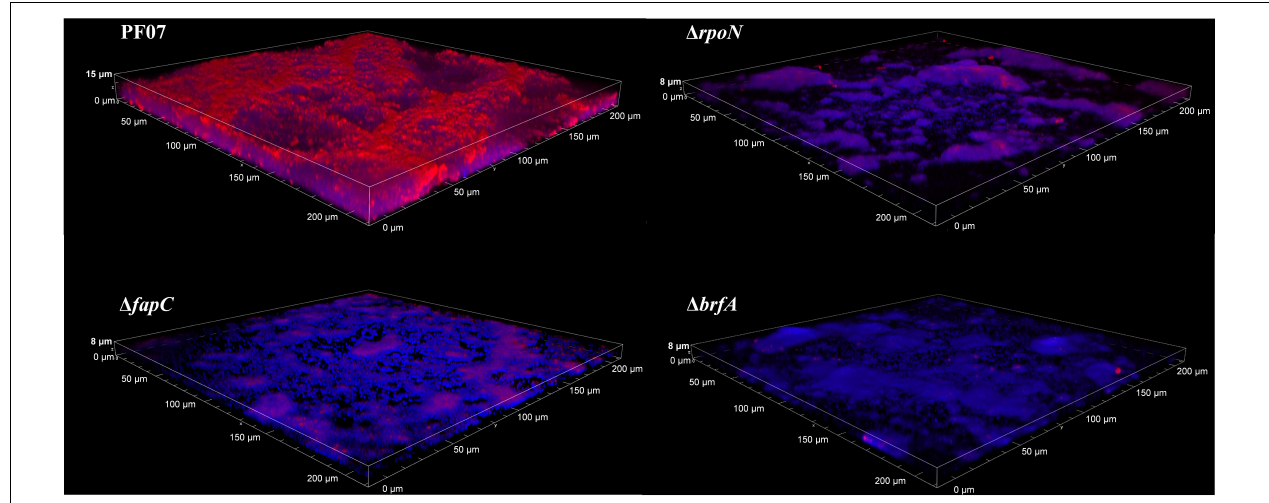
FIGURE 5 | CLSM observation of biofilm on glass slips of PF07, (cid:49) fapC , (cid:49) rpoN , and (cid:49) b rfA . The biofilms were grown along the air-liquid interface of 20-mm glass coverslips. At 24 h the coverslips were removed, washed in 0.9% NaCl, and stained with DAPI for cells (blue) and Congo red for extracellular matrix (Red). Shown are representative images of each